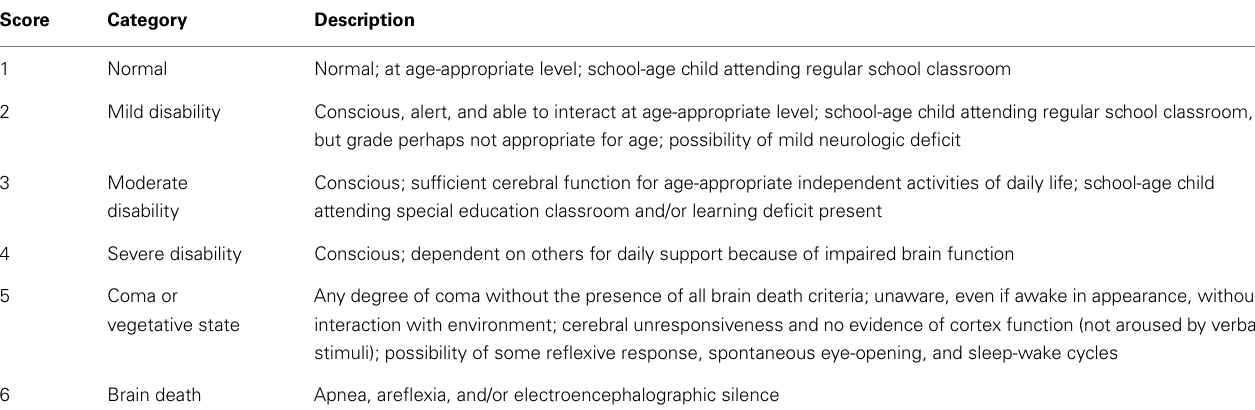
Table 1 | Pediatric cerebral performance category scale.